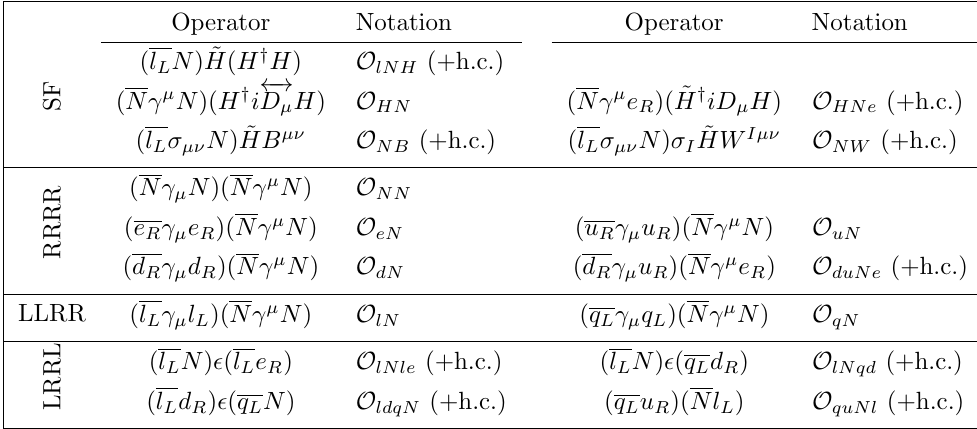
Table 1 . Basis of lepton and baryon number conserving dimension-six operators containing a RH neutrino N [7]. l L and q L stand for the left-handed lepton and quark doublets, respectively. Likewise, e R and u R and d R stand for the right-handed leptons and the up and down quarks, respectively. We use the symbol H to denote the Higgs doublet, while ~ H = (cid:15)H (cid:3) , where (cid:15) is the fully antisymmetric tensor in two dimensions. B (cid:22)(cid:23) and W I represent the weak (cid:12)eld strength (cid:22)(cid:23) tensors. Flavour indices are not shown